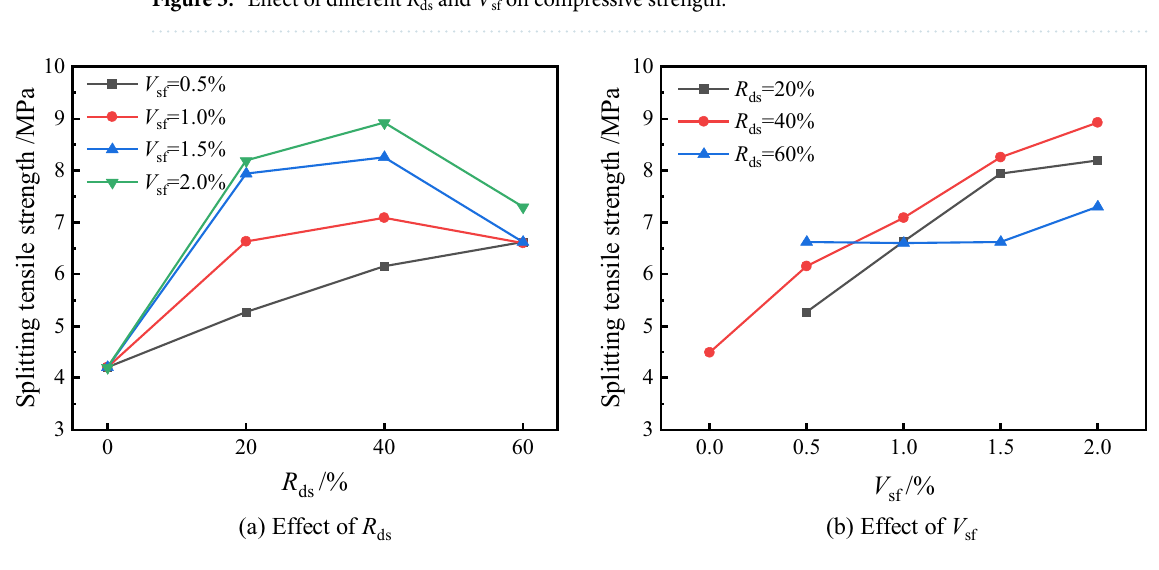
Figure 6. Effect of different R ds and V sf on splitting tensile